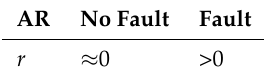
Table 2. Signature